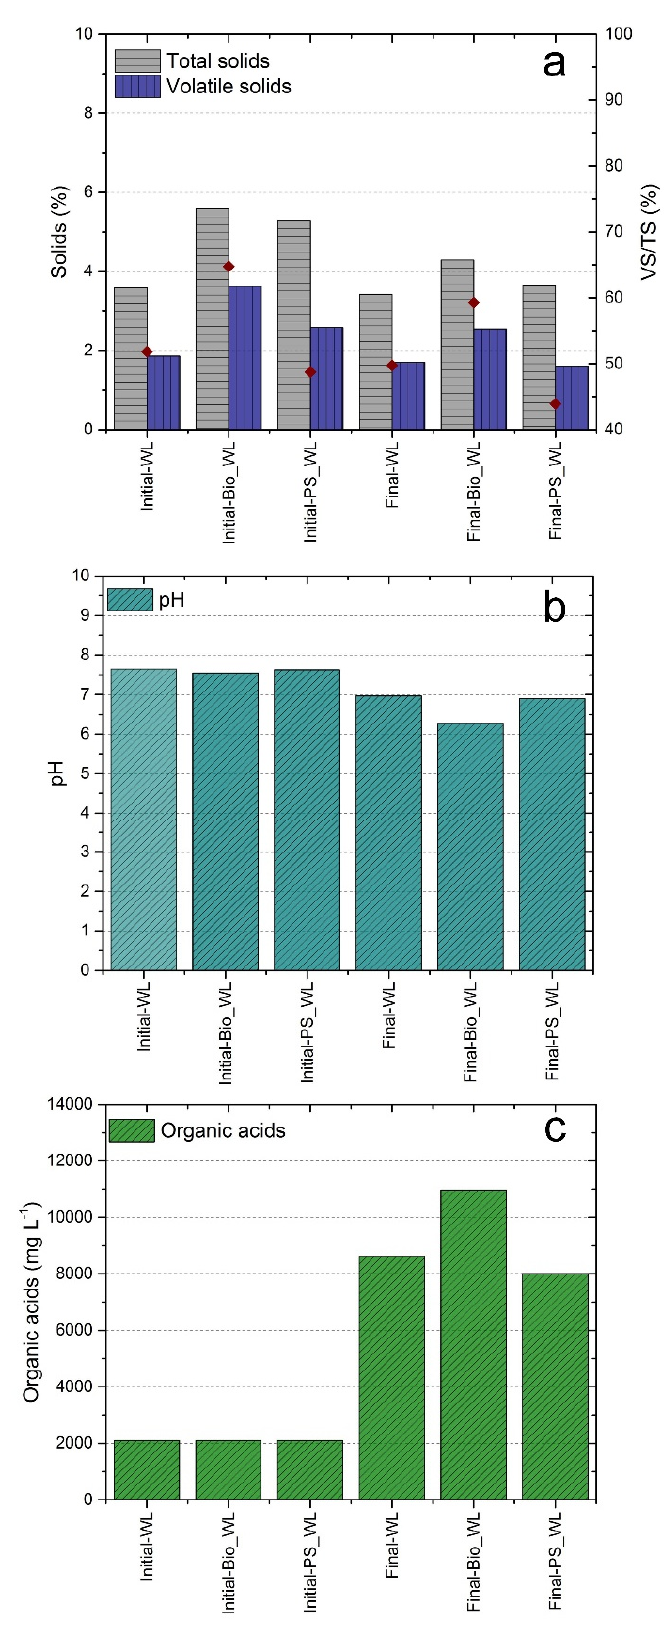
Figure 6. Comparison of physico-chemical characteristics of substrates (initial values) and digestates (final values): ( a ) TS and VS (%) and VS / TS (% of TS); ( b ) initial and final pH values; ( c ) total VFAs (mg L − 1 ).